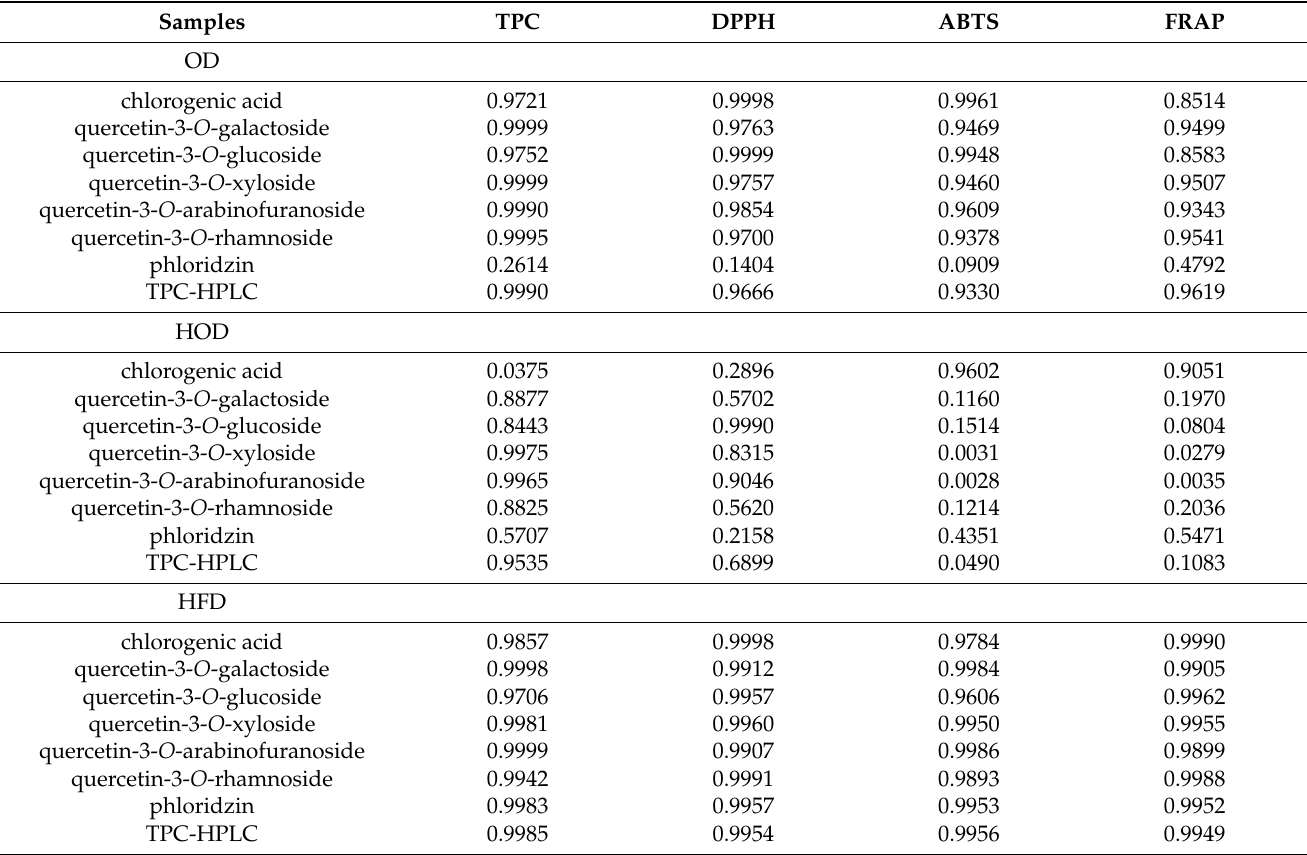
Table 5. Correlation analysis (coefficient of determination, R 2 ) between HPLC data (individual phenol content and TPC-HPLC) and spectrophotometric results (TPC, DPPH, ABTS, FRAP), taking into consideration AP samples subjected to different treatment (OD, HOD,